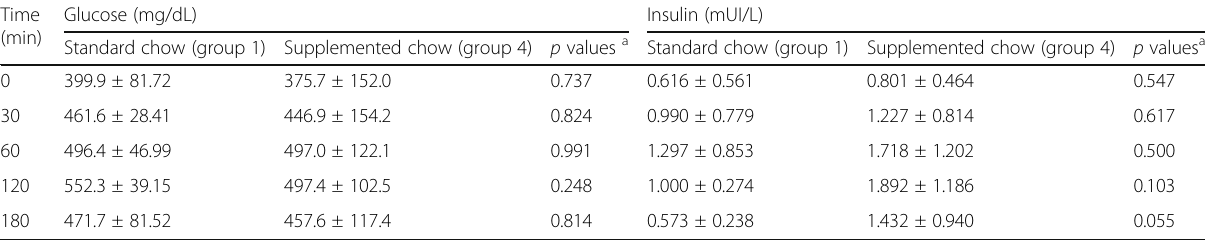
Table 2 Glucose and insulin concentrations obtained after the administration of an oral 3 g glucose load to diabetic rabbits ( n = 6) treated with an intravenous metformin dose of 30 mg/kg Time Glucose (mg/dL) Insulin (min)